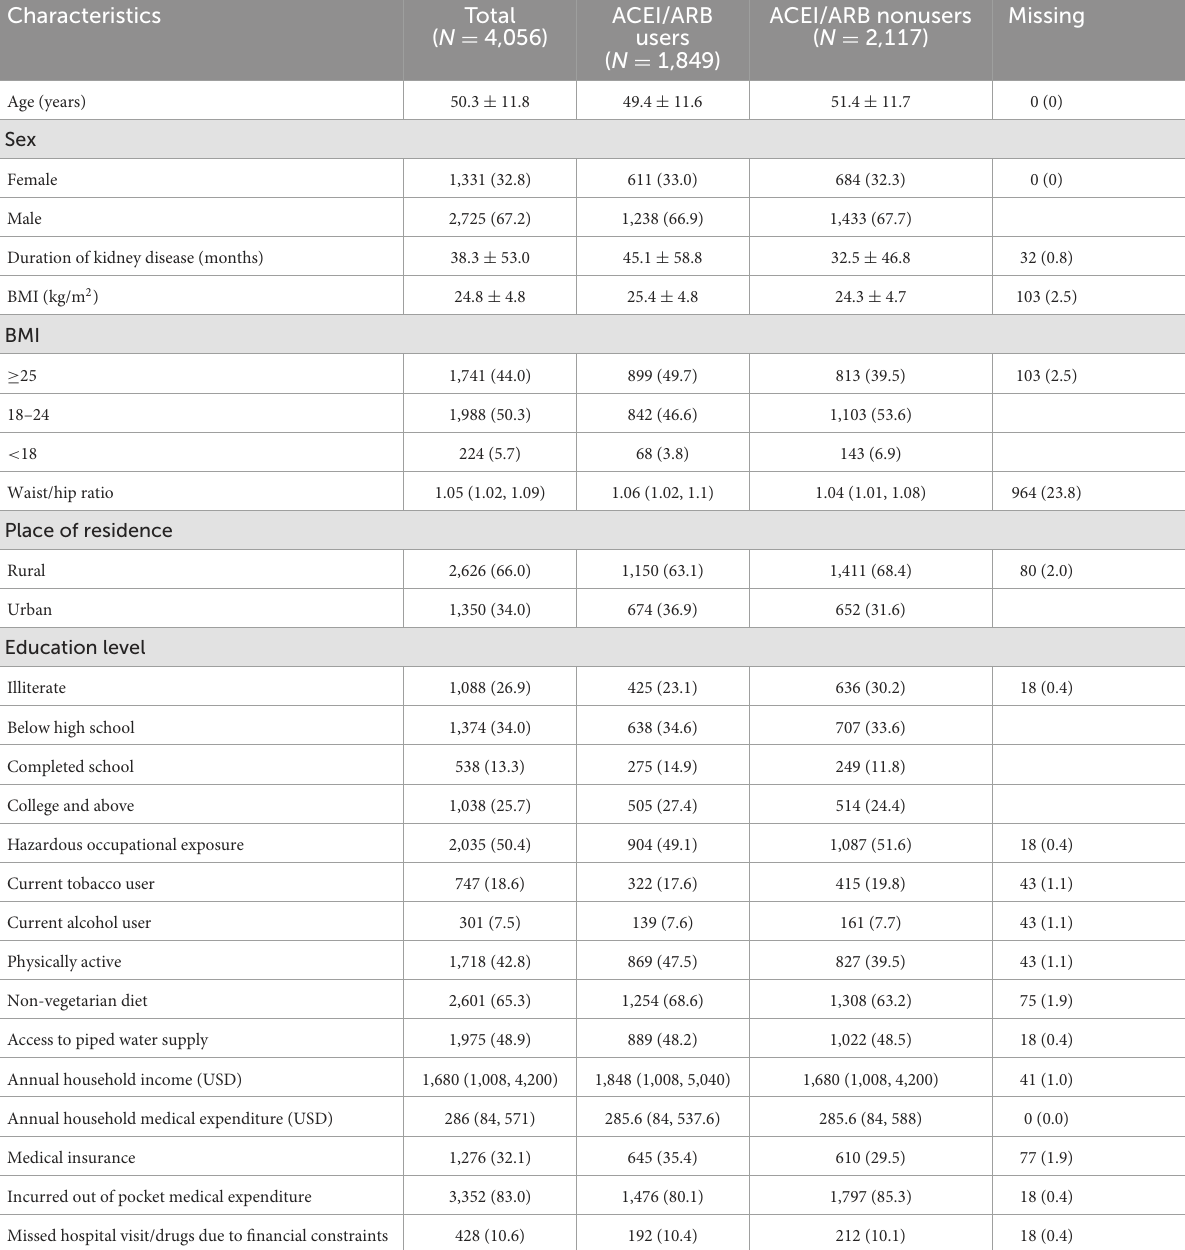
TABLE 1 Baseline sociodemographic characteristics of participants in the study. Characteristics